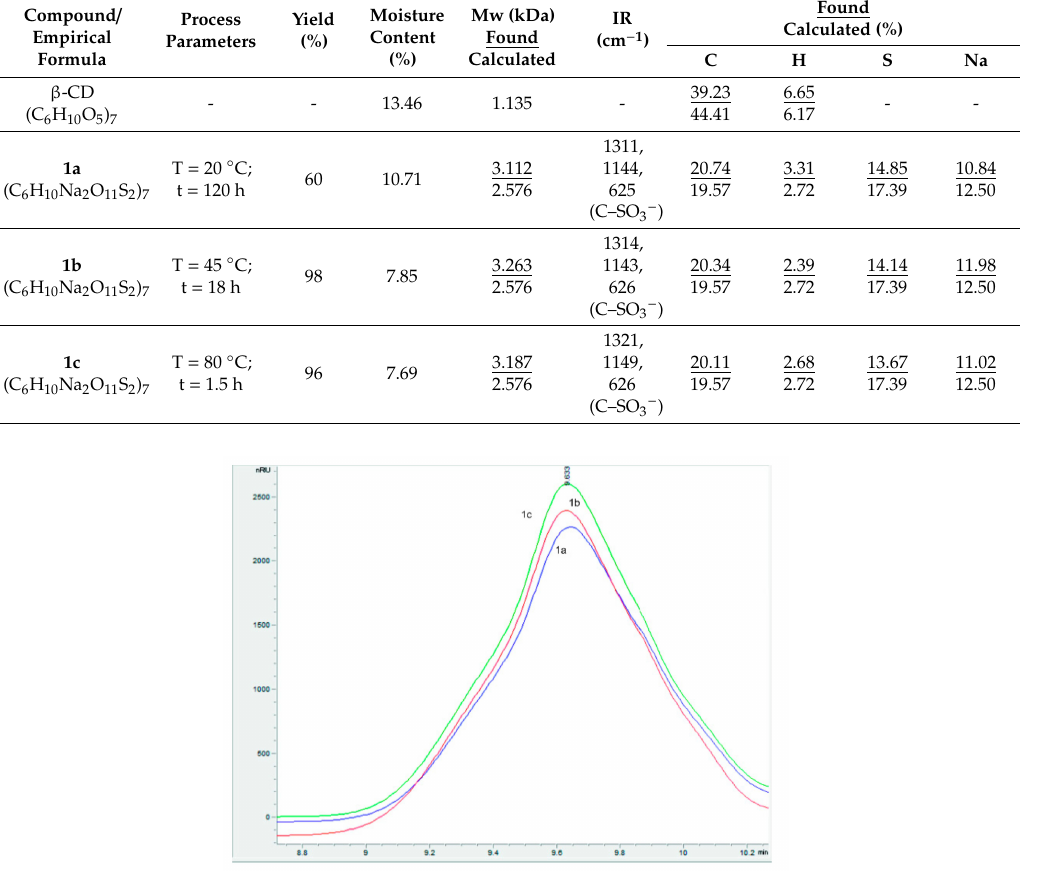
Table 2. Physical–chemical characteristics of compounds 1a–c .